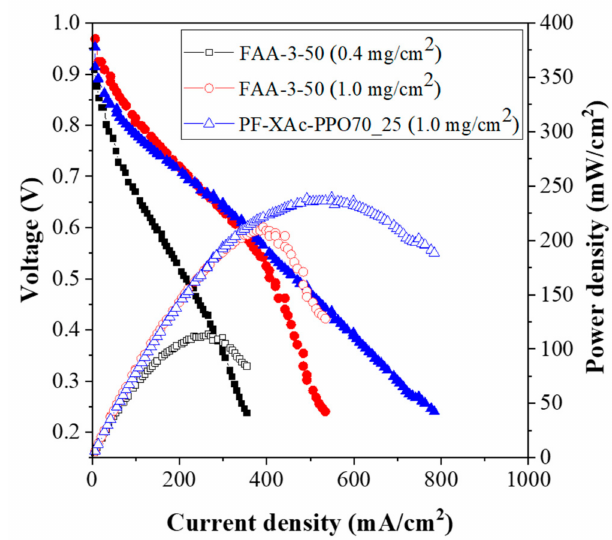
Figure 9. Cell test results of the XAc-PPO70_25 under H 2 / O 2 conditions and 100% RH at 60 ◦